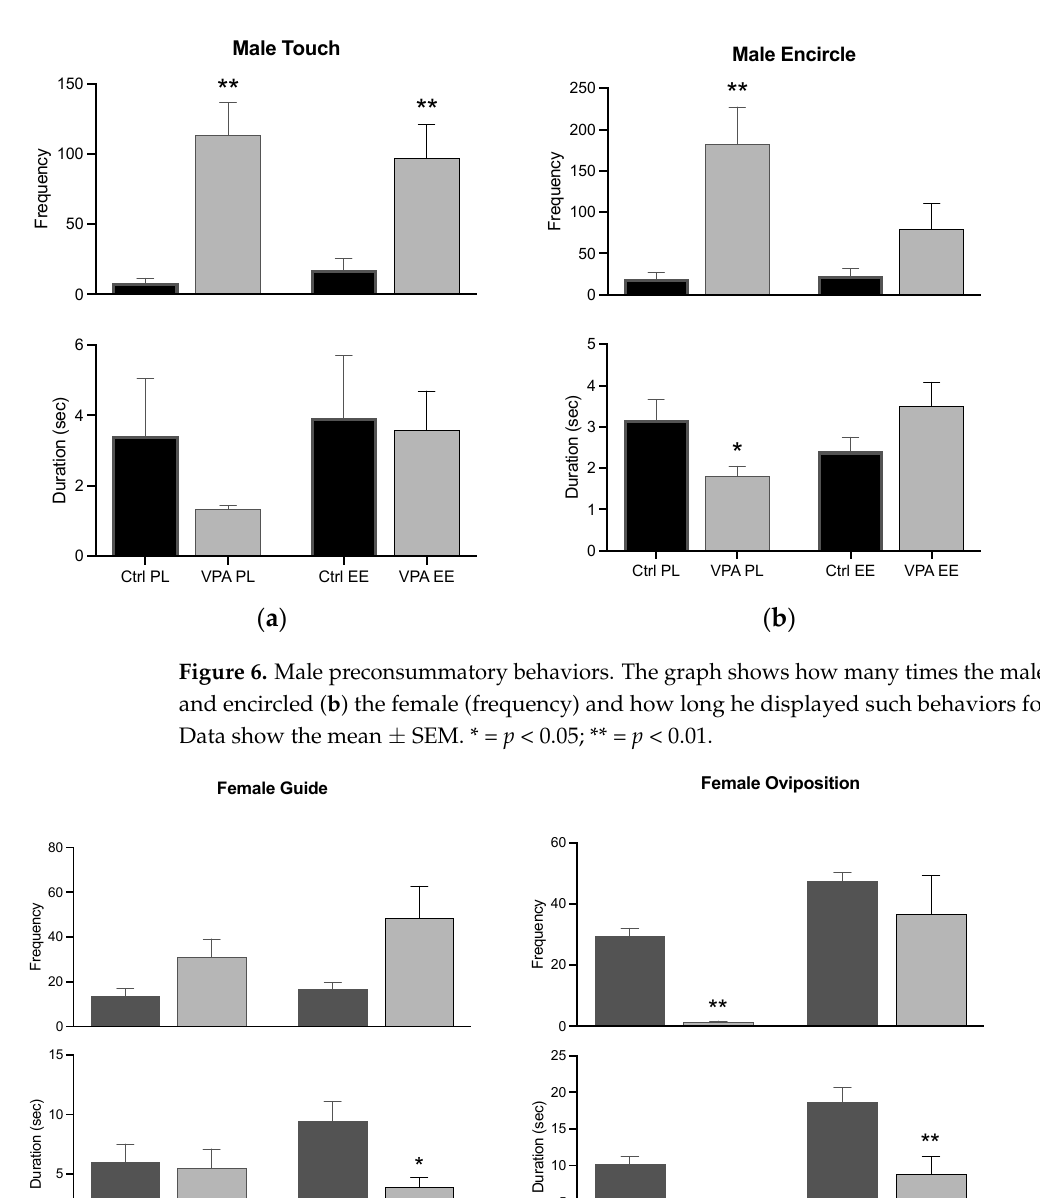
Figure 7. Female consummatory behaviors. The graph shows how many times the female guided the male ( a ) and displayed oviposition ( b ) (frequency), and how long she displayed such behaviors for (duration). Data show the mean ± SEM. * = p < 0.05; ** = p < 0.01.